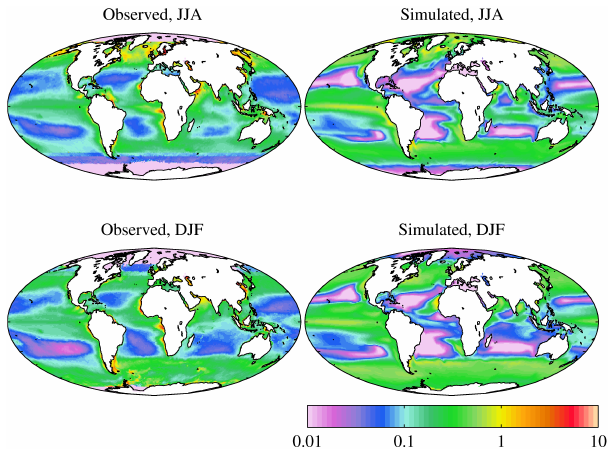
Fig. 11. Observational (SeaWiFS ; left ) and simulated ( right ) surface chlorophyll for northern summer (June–July– August; top ) and northern winter (December–January–February; bottom ). Concentrations in mg chl. m − 3 .